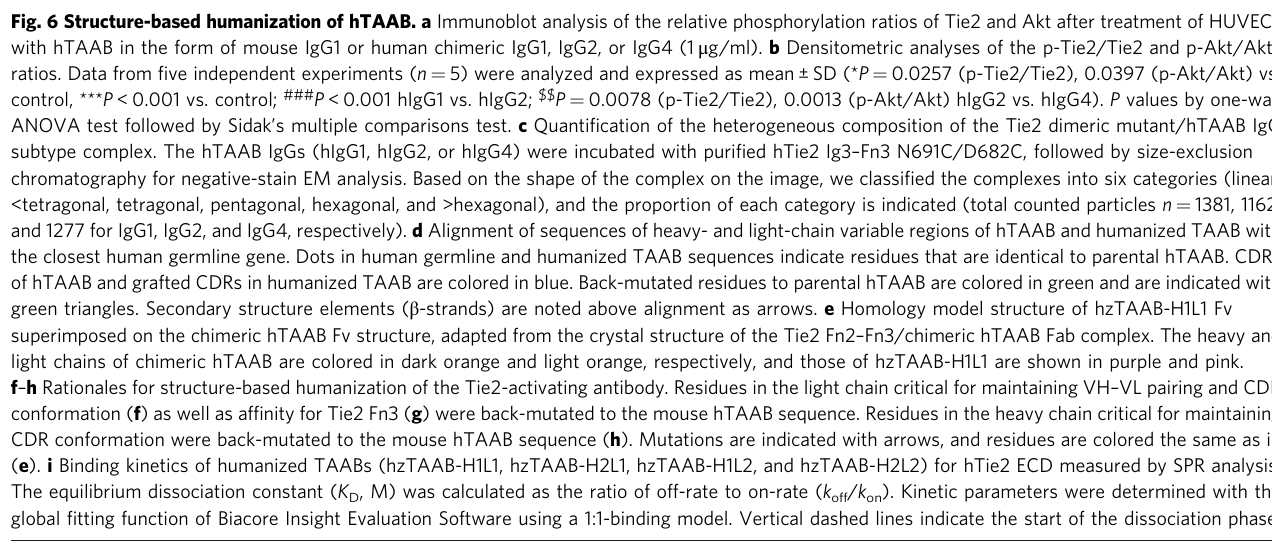
Fig. 6 Structure-based humanization of hTAAB. a Immunoblot analysis of the relative phosphorylation ratios of Tie2 and Akt after treatment of HUVECs with hTAAB in the form of mouse IgG1 or human chimeric IgG1, IgG2, or IgG4 (1 μ g/ml). b Densitometric analyses of the p-Tie2/Tie2 and p-Akt/Akt ratios. Data from fi ve independent experiments ( n = 5) were analyzed and expressed as mean ± SD (* P = 0.0257 (p-Tie2/Tie2), 0.0397 (p-Akt/Akt) vs. control, *** P < 0.001 vs. control; ### P < 0.001 hIgG1 vs. hIgG2; $$ P = 0.0078 (p-Tie2/Tie2), 0.0013 (p-Akt/Akt) hIgG2 vs. hIgG4). P values by one-way ANOVA test followed by Sidak ’ s multiple comparisons test. c Quanti fi cation of the heterogeneous composition of the Tie2 dimeric mutant/hTAAB IgG subtype complex. The hTAAB IgGs (hIgG1, hIgG2, or hIgG4) were incubated with puri fi ed hTie2 Ig3 – Fn3 N691C/D682C, followed by size-exclusion chromatography for negative-stain EM analysis. Based on the shape of the complex on the image, we classi fi ed the complexes into six categories (linear, <tetragonal, tetragonal, pentagonal, hexagonal, and >hexagonal), and the proportion of each category is indicated (total counted particles n = 1381, 1162, and 1277 for IgG1, IgG2, and IgG4, respectively). d Alignment of sequences of heavy- and light-chain variable regions of hTAAB and humanized TAAB with the closest human germline gene. Dots in human germline and humanized TAAB sequences indicate residues that are identical to parental hTAAB. CDRs of hTAAB and grafted CDRs in humanized TAAB are colored in blue. Back-mutated residues to parental hTAAB are colored in green and are indicated with green triangles. Secondary structure elements ( β -strands) are noted above alignment as arrows. e Homology model structure of hzTAAB-H1L1 Fv superimposed on the chimeric hTAAB Fv structure, adapted from the crystal structure of the Tie2 Fn2 – Fn3/chimeric hTAAB Fab complex. The heavy and light chains of chimeric hTAAB are colored in dark orange and light orange, respectively, and those of hzTAAB-H1L1 are shown in purple and pink. f – h Rationales for structure-based humanization of the Tie2-activating antibody. Residues in the light chain critical for maintaining VH – VL pairing and CDR conformation ( f ) as well as af fi nity for Tie2 Fn3 ( g ) were back-mutated to the mouse hTAAB sequence. Residues in the heavy chain critical for maintaining CDR conformation were back-mutated to the mouse hTAAB sequence ( h ). Mutations are indicated with arrows, and residues are colored the same as in ( e ). i Binding kinetics of humanized TAABs (hzTAAB-H1L1, hzTAAB-H2L1, hzTAAB-H1L2, and hzTAAB-H2L2) for hTie2 ECD measured by SPR analysis. The equilibrium dissociation constant ( K D , M) was calculated as the ratio of off-rate to on-rate ( k off / k on ). Kinetic parameters were determined with the global fi tting function of Biacore Insight Evaluation Software using a 1:1-binding model. Vertical dashed lines indicate the start of the dissociation